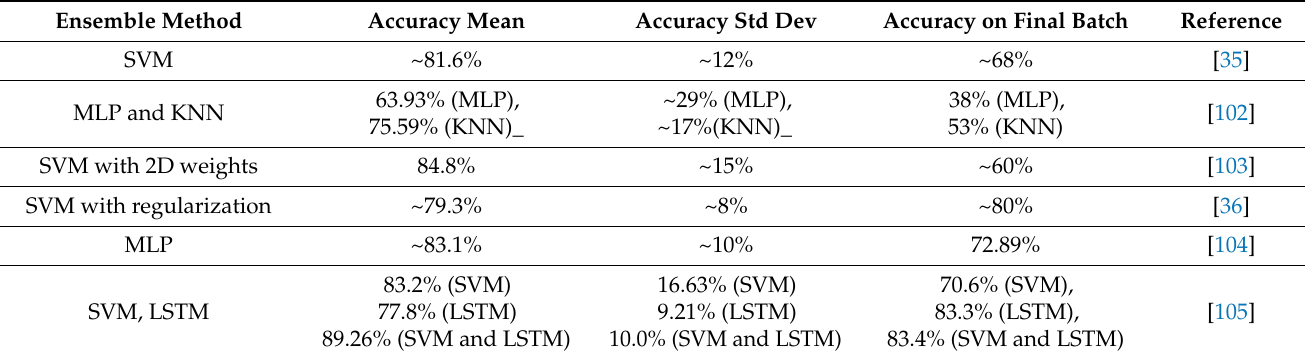
Table 5. Summary for drift compensation by